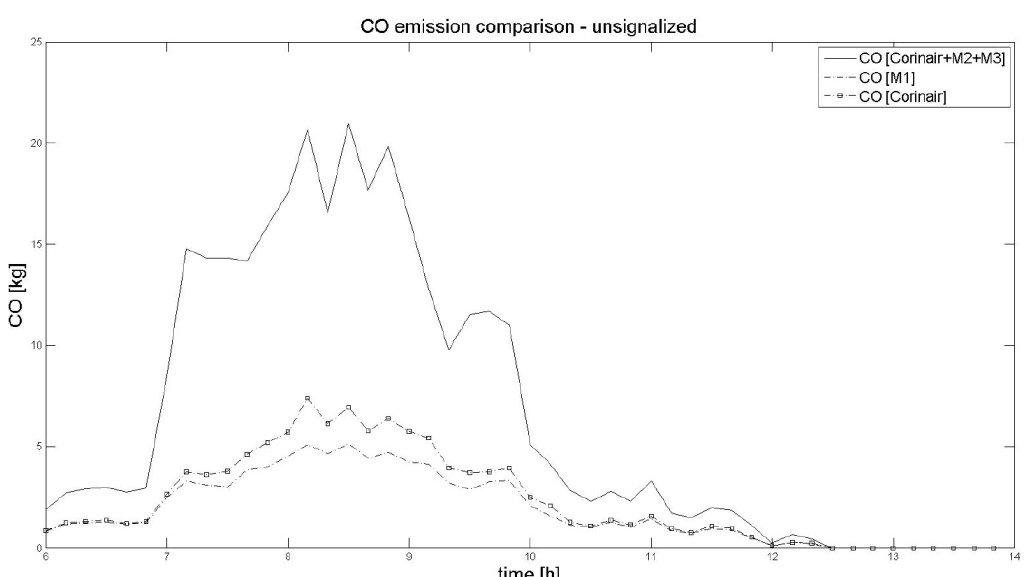
Figure 13. CO distribution with the three methods only for links approaching unsignalized intersections